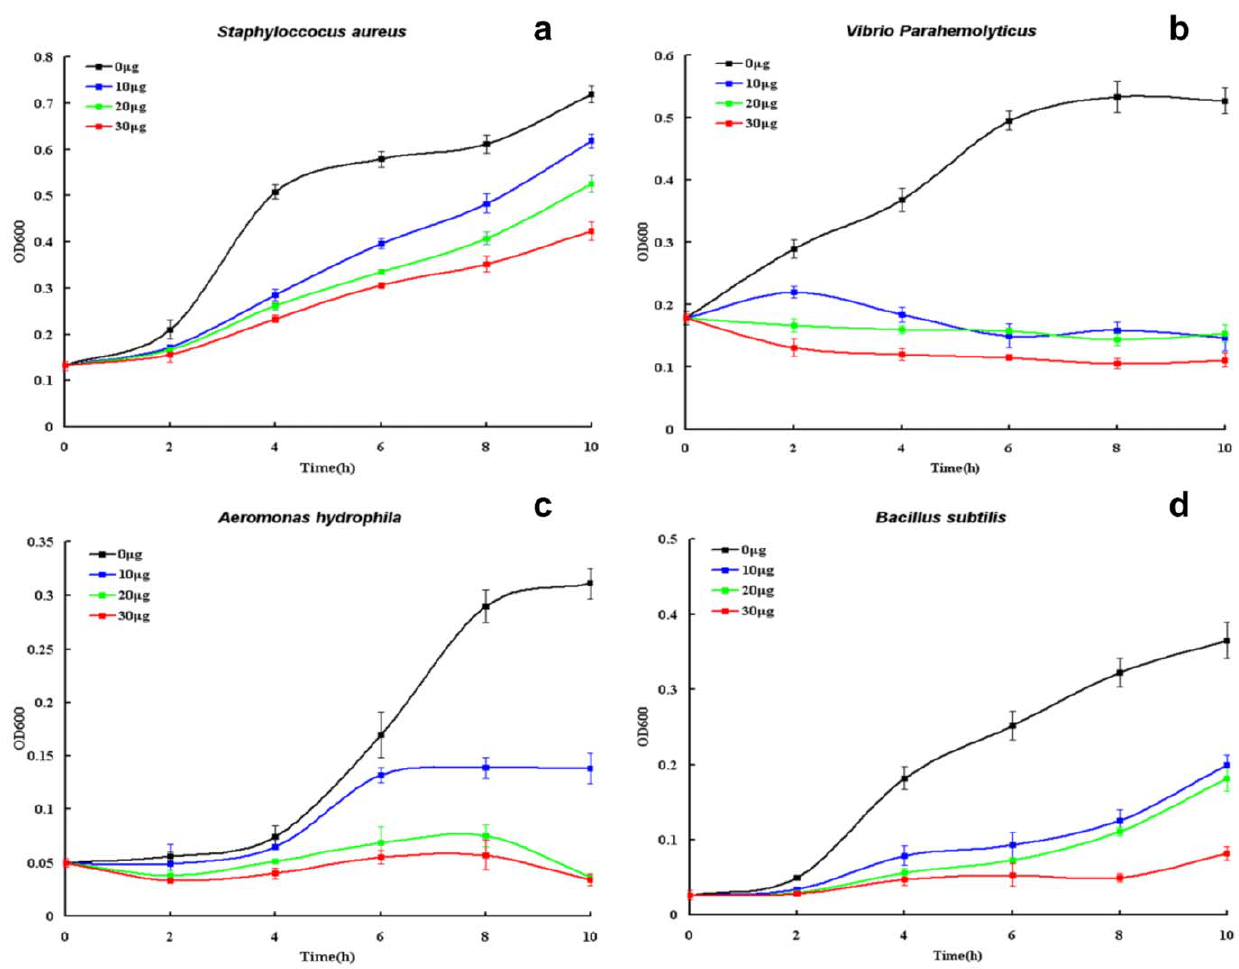
Figure 5. Bacterial agglutination activity assay towards Gram-negative bacteria E.coli and Gram-positive bacteria S.aureus . E. coli was in (a, b, e, f, i, j) and S. aureus was in (c, d, g, h, k, l). (a–d) were incubated with rTrx as a control, (e–h) were incubated with rEs-FABP9 and (i–l) were incubated with rEs-FABP10. The proteins’ final quantity of (a–l) are different as followed. (a, c): rTrx, 5 m g, (b, d): rTrx, 10 m g; (e, g): rEs-FABP9, 5 m g, (f, h): rEs-FABP9, 10 m g; (i, k): rEs-FABP10, 5 m g, (j, l): rEs-FABP10, 10 m g.